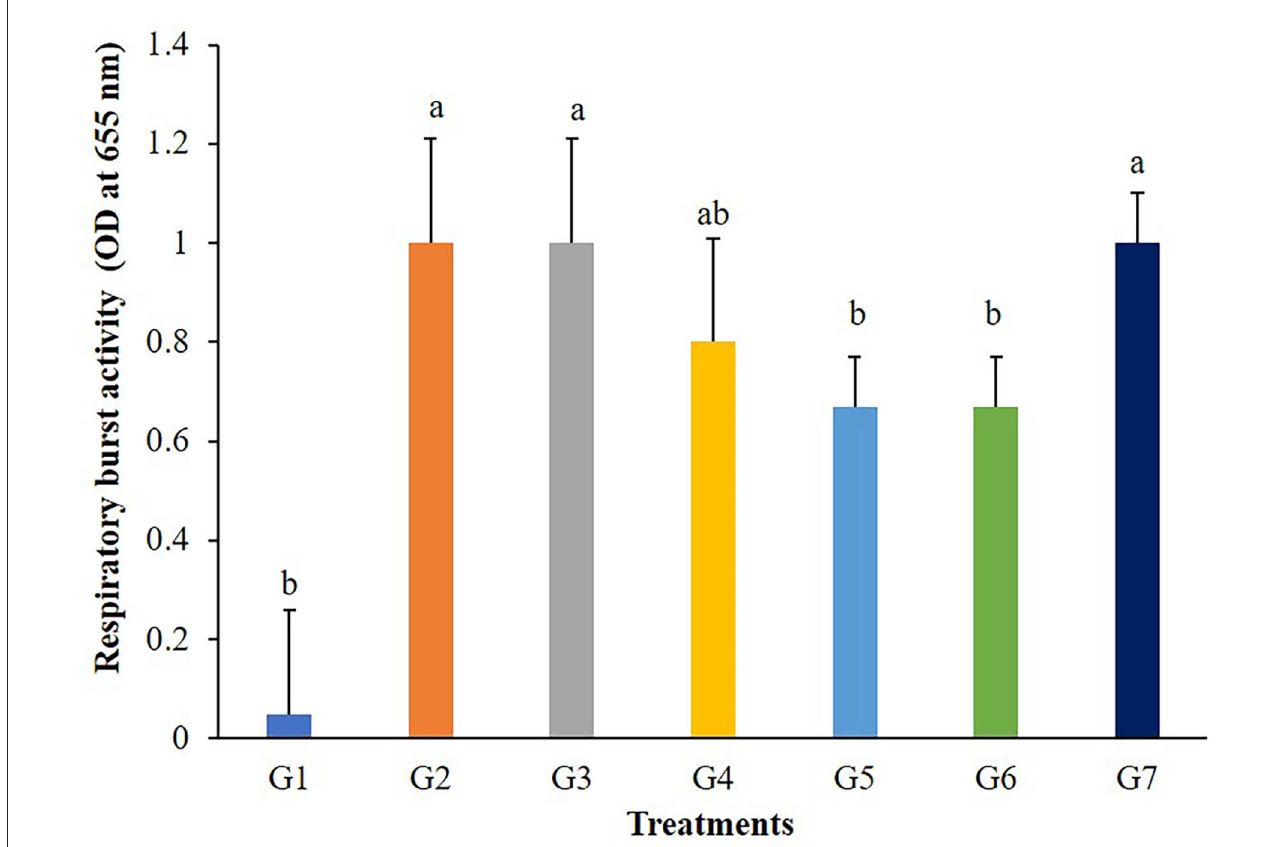
FIGURE4 Respiratory burst activity of Nile tilapia fed with FOS and B. subtilis for 56 days ( n = 5). Bars with different letters indicate significant difference ( P < 0.05).